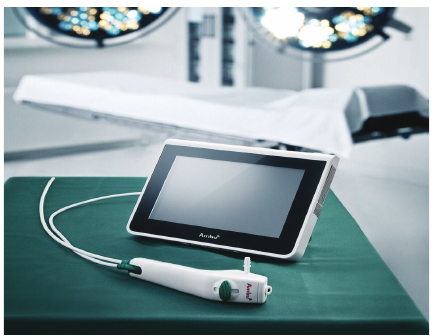
Figure 2: The aScope-2 with a transportable